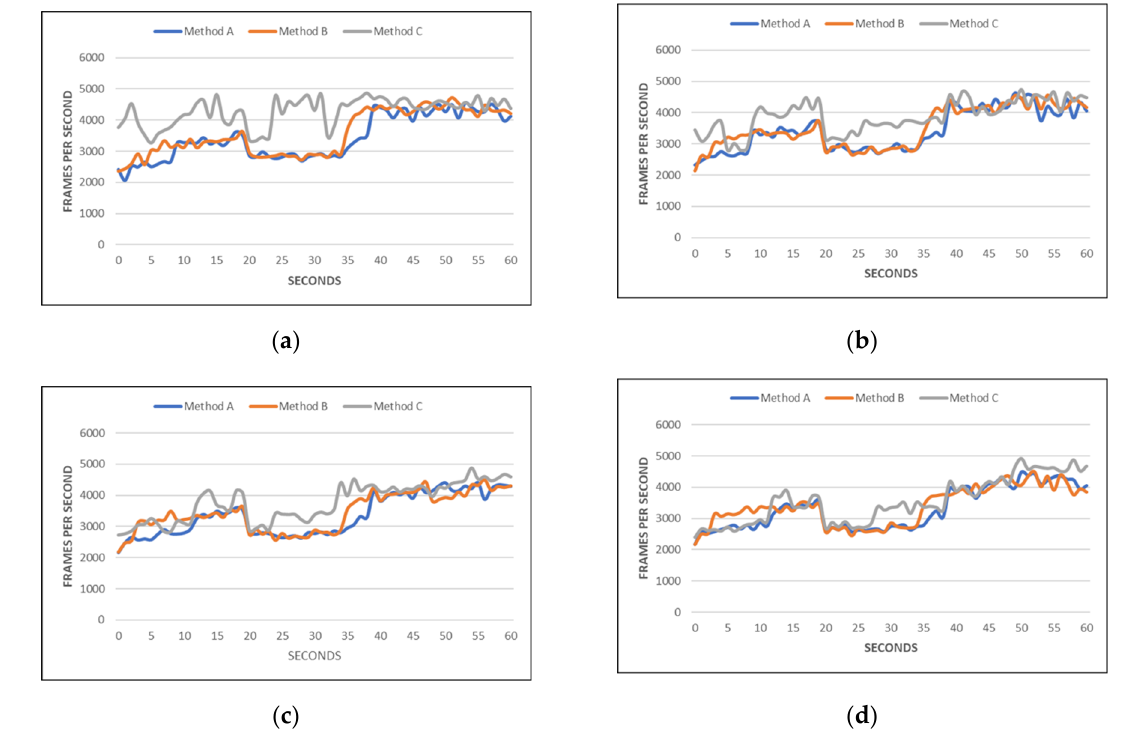
Figure 14. Comparison among different methods. ( a ) Average camera heights of 884 m. ( b ) Average camera heights of